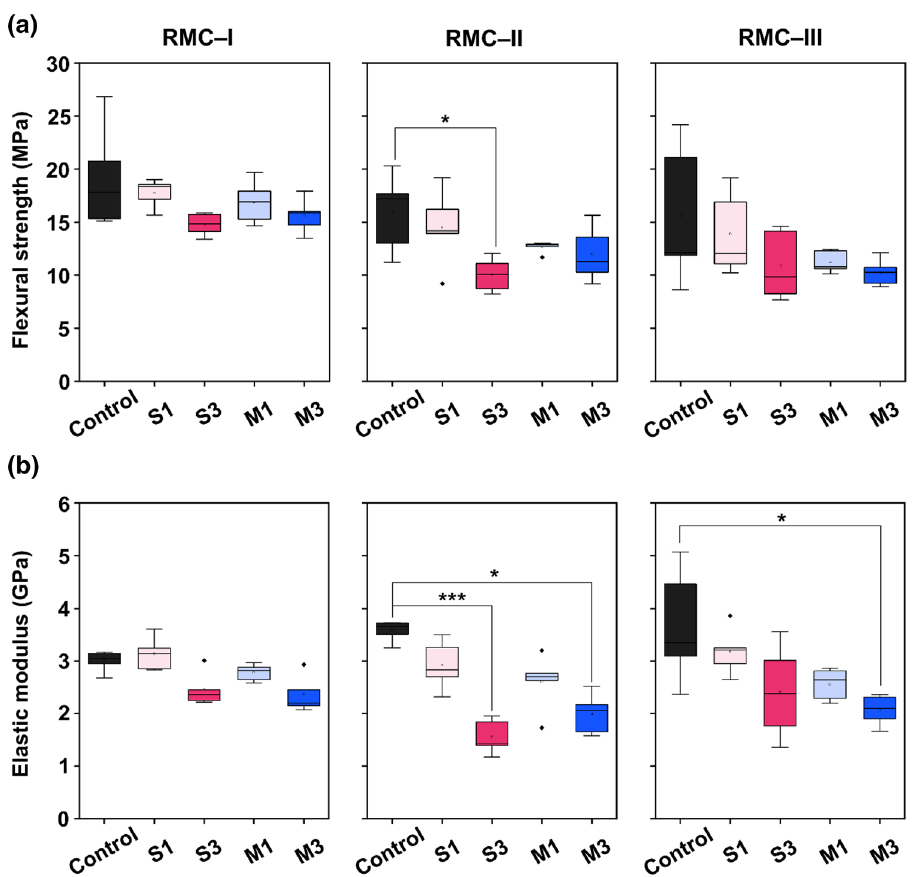
Figure 7. Flexural strength ( a ) and elastic modulus ( b ) of ZD-modified RMGICs. A varying number of asterisks indicate significant differences by post-hoc Dunn’s test (* P < 0.05, *** P < 0.001). ZD; zwitterionic derivatives, RMGIC; resin-modified glass ionomer